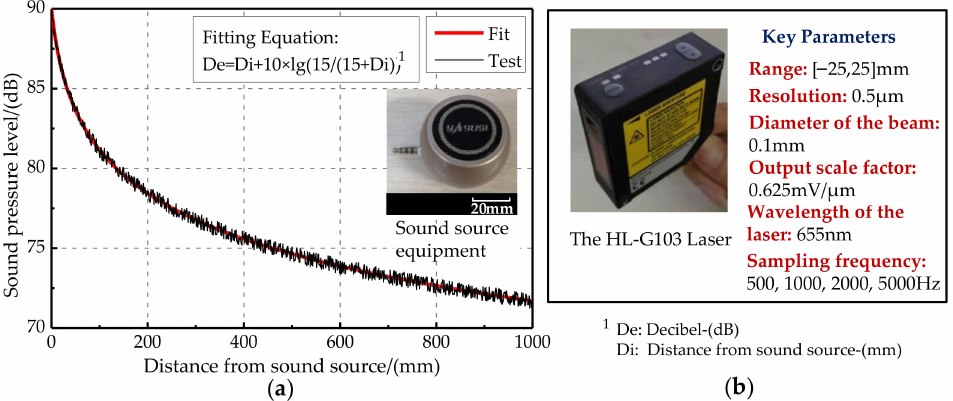
Figure 14. Characteristics of key equipment. ( a ) Characteristics of the sound source equipment. ( b ) Characteristics of the